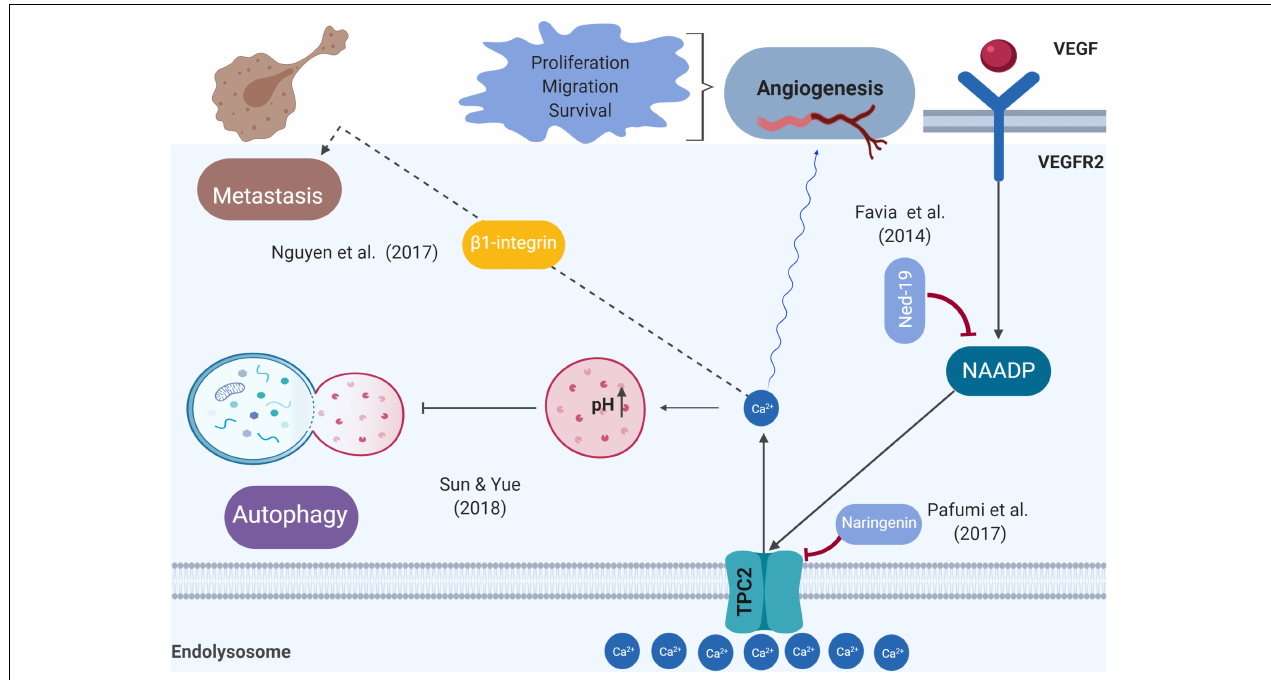
FIGURE 1 | Schematic representation of the role of TPC2 in the pathophysiological processes related to cancer. Previous studies demonstrated that the VEGFR2/NAADP/TPC2/Ca 2 + signaling pathway is critical for VEGF-induced angiogenesis in vitro and in vivo